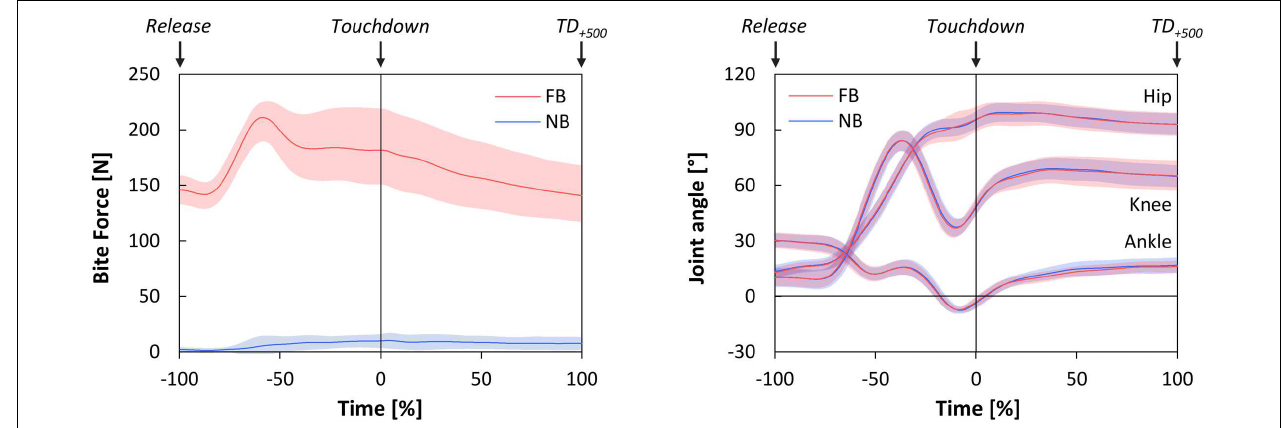
FIGURE 2 | Time-normalized bite forces (left), and time-normalized joint angles of the hip, knee, and ankle joints in sagittal plane (right) during Falling phase and Stance phase as functions of oral motor tasks (FB, force-controlled biting; NB, non-biting). Falling phase : from Release until Touchdown (normalized from − 100 to 0%); Stance phase : from Touchdown until 500 ms after Touchdown ( TD + 500 ) (normalized from 0 to 100%). All data are presented as mean ± CI 95 . TABLE 2 | Joint flexion angles at Touchdown , and maximum joint flexion angles during Stance phase for force-controlled biting (FB) and non-biting (NB). FB